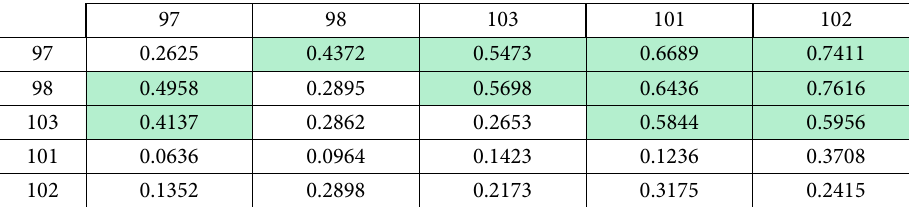
Table 21. Total influence matrix